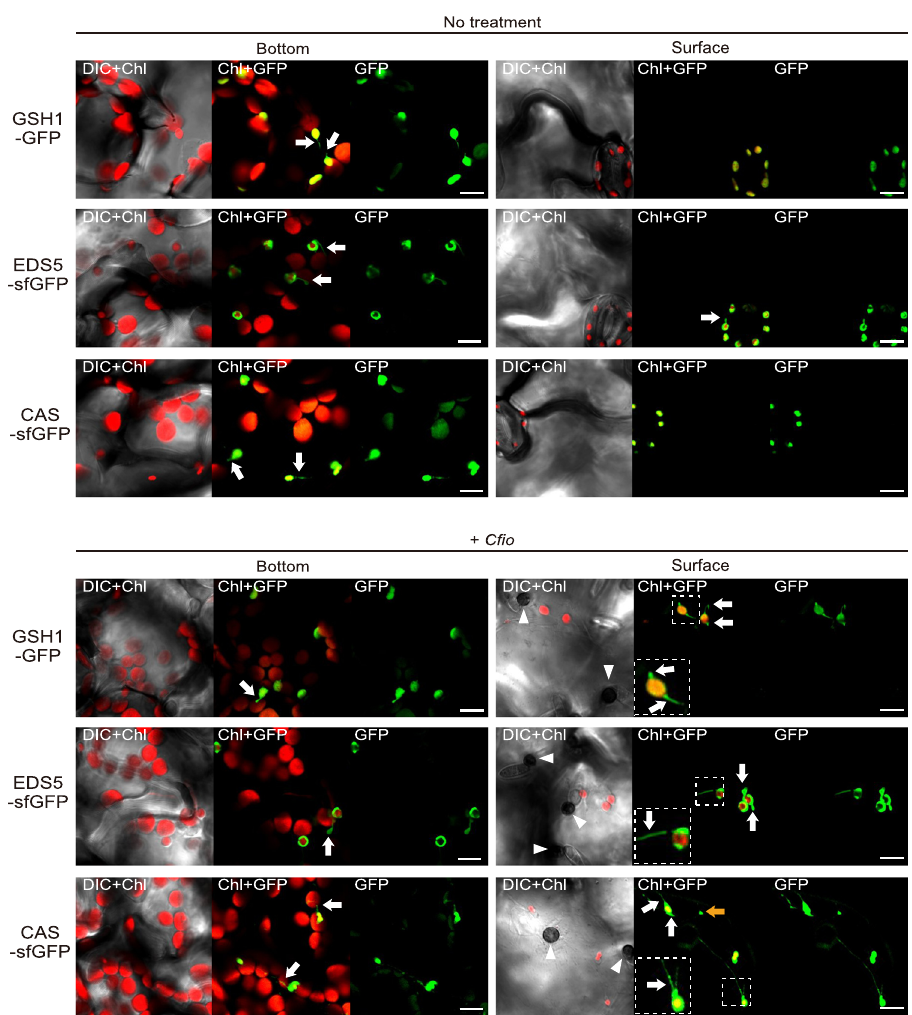
Fig. 5 Epidermal chloroplasts preferentially position immune components GSH1, EDS5, and CAS. Localization patterns of GSH1, EDS5, and CAS proteins in Arabidopsis . The transgenic gsh1 mutant expressing GSH1-GFP 46 under its own promoter and Col-0 plants expressing EDS5-sfGFP and CAS-sfGFP under the CaMV 35S promoter were incubated with or without C fi o and observed at 2 dpi. Chloroplasts were visualized using chlorophyll auto fl uorescence. The lower left dashed-line square regions show a magni fi ed image of the dashed box. The white arrowheads and arrows indicate melanized appressoria and stromules, respectively. The orange arrow indicates CAS localized in the epidermal plastid without chlorophyll. Scale bar, 10 µ m. Similar results were obtained from three independent